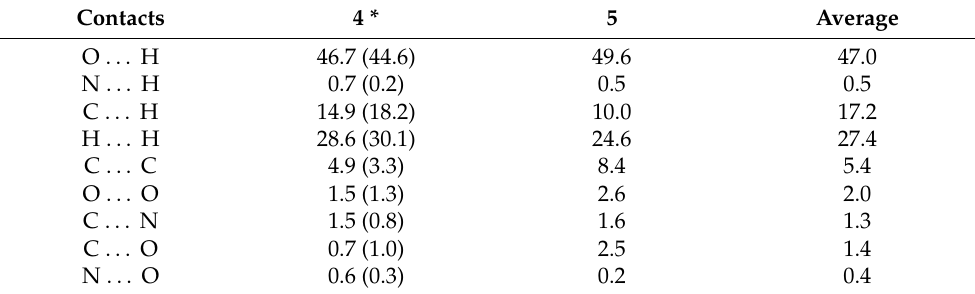
Table 3. Contributions (%) of various interactions into the Hirshfeld surface of the gallate anion in 4 and 5